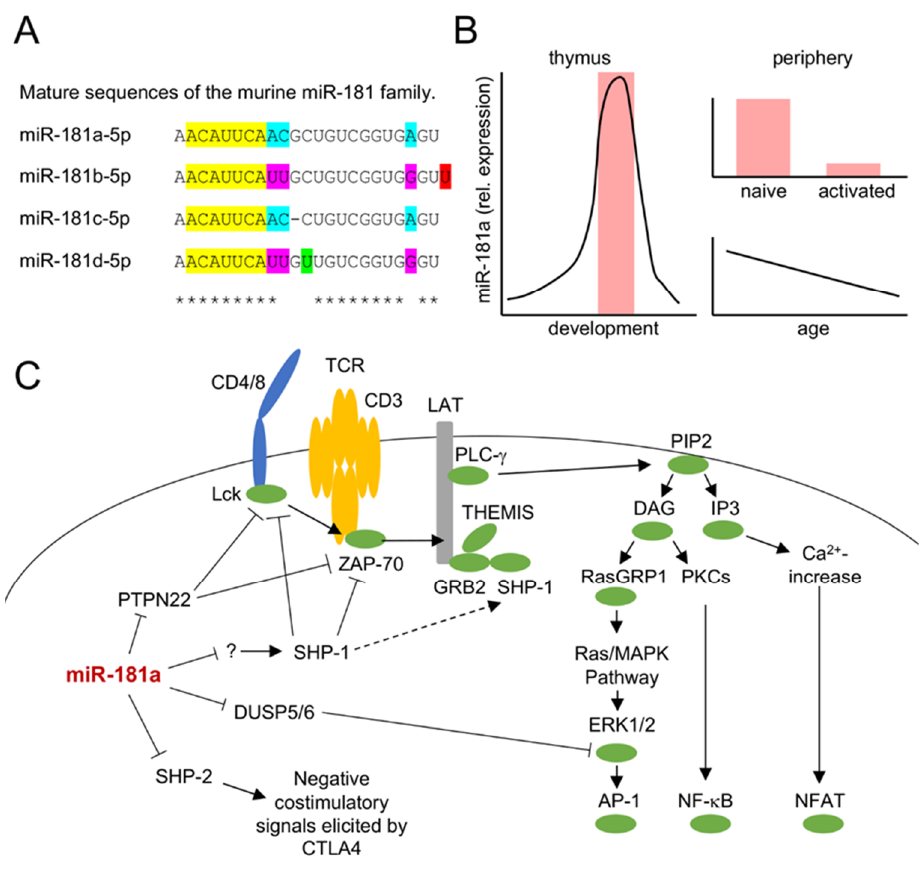
Figure 2. Characteristics of the miR-181 family. ( A ) Mature sequences of murine miR-181a, b, c, and d. Seed sequences are marked in yellow, asterisks indicate the consensus bases of all four microRNAs. Colored boxes highlight differences between family members. ( B ) Dynamic expression profiles of miR-181a(/b-1) in T cells from thymus (left) and periphery (right). The shaded area in the thymus indicates the phase of thymic selection. ( C ) Schematic depiction of miR-181a targets in the TCR signaling cascade. Positive and negative signaling relationships are indicated by solid lines. miR-181a targets PTPN22, DUSP5/6, and SHP-2, which, in turn, regulate Lck and ZAP-70, Erk1/2 and negative costimulatory signals elicited by CTLA4, respectively. Additionally, an indirect effect of miR-181a on SHP-1 has been proposed (denoted by question mark and dotted arrow).